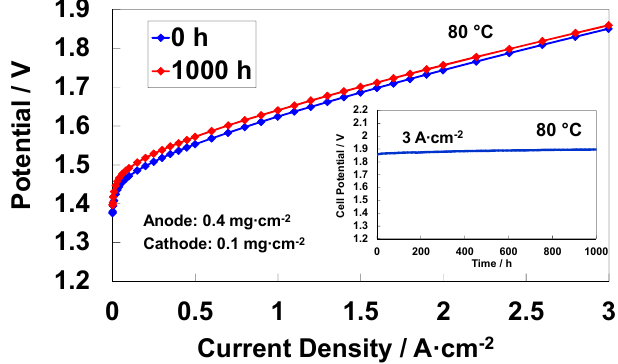
Figure 11. Polarization curves at 80 °C before and after a 1000 h durability test for a low-loading MEA (both low anode 0.4 mg cm − 2 and cathode 0.1 mg cm − 2 loadings). The inset shows the durability tests at 3 A ∙ cm − 2 .